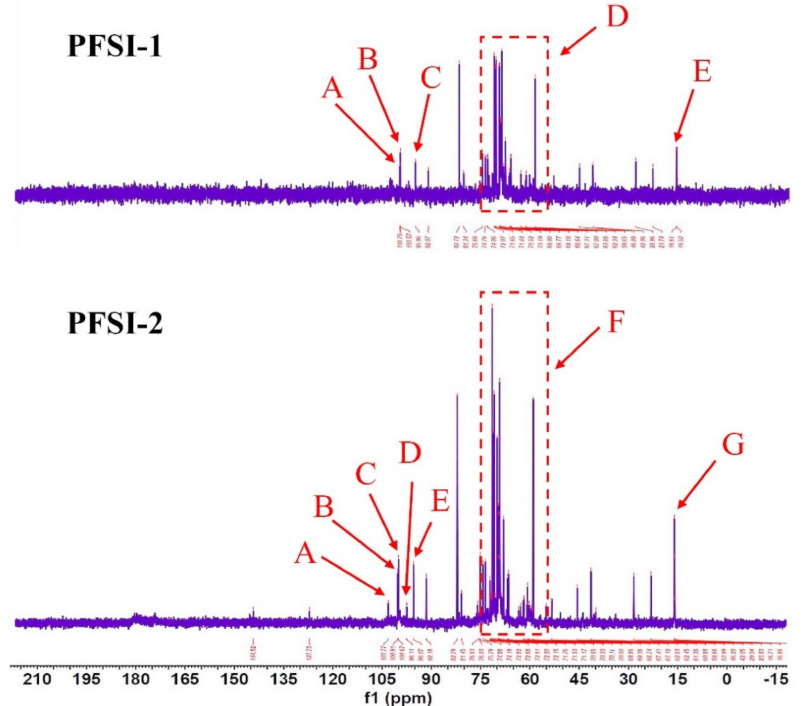
Figure 7. PFSI-1, PFSI-2 NMR carbon spectra (13C NMR). Note: PFSI-1 and PFSI-2 are mainly present with α -configuration saccharide groups. The chemical shift signals appeared as heterocapsid carbon signal peaks with δ 100.76 (A), 100.57 (B), 95.96 (C) ppm and δ 103.77 (A), 100.91 (B), 100.67 (C), 98.14 (D), 96.07 ppm, respectively. The δ values of C 2 to C 5 signals in PFSI-1 (part D) and PFSI-2 (part F) are all concentrated between δ 65 and 77, indicating that most of them have not been replaced yet. There are chemical shifts between δ 55 and 65, illustrating that the hydroxyl group at position C6 is partly substituted and partly unsubstituted. The chemical shifts at δ 16.52 (E) and δ 16.55 (G) in PFSI-1 and PFSI-2 are the C 6 of rhamnose.